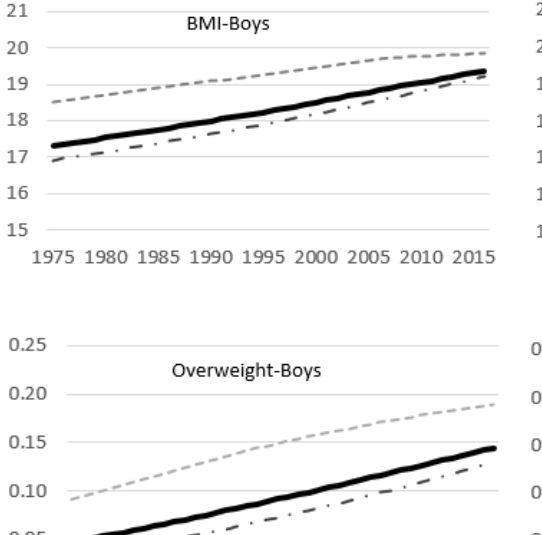
Figure A2. BMI, overweight and obesity evolution by gender and region.